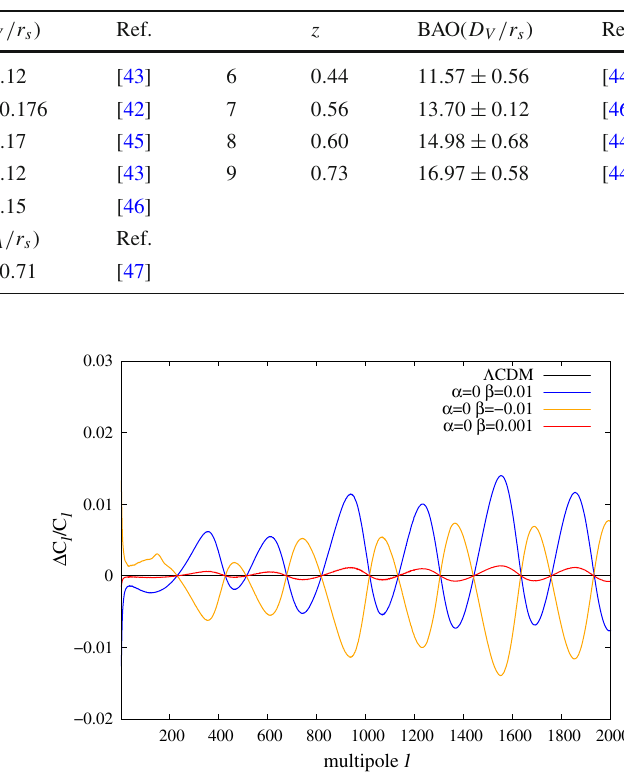
Fig. 2 Ratio of (cid:17) C (cid:18) / C (cid:18) , where (cid:17) C (cid:18) is the change between the RVM and (cid:2) CDM for the TT mode of the CMB power spectra, while C (cid:18) corresponds to the one in (cid:2)